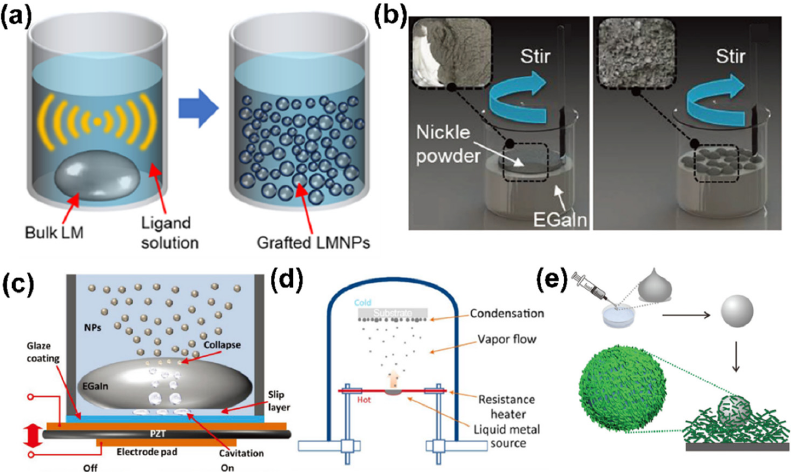
Figure 2. Basic synthesis methods of liquid metal-based nano-composites. ( a ) Ultrasound. Reprinted with permission from Ref. [41]. Copyright 2020 MDPI. ( b ) Shear mixing. Reprinted with permission from Ref. [43] Copyright 2018 John Wiley and Sons. ( c ) Nebulization. Reprinted with permission from Ref. [45] Copyright 2018 John Wiley and Sons. ( d ) Physical vapor deposition. Reprinted with permission from Ref. [46] Copyright 2018 Elsevier. ( e ) Surface rolling coating. Reprinted with permission from Ref. [47] Copyright 2017 Royal Society of Chemistry.